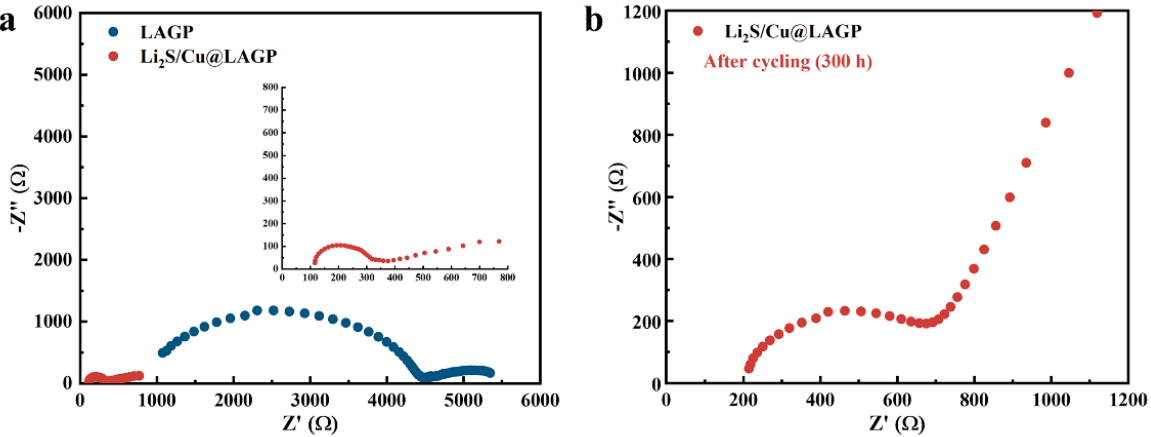
Figure 6. ( a ) Nyquist plots of Li|Li 2 S/Cu@LAGP|Li and Li|LAGP|Li cells. ( b ) Nyquist plot of the Li|Li 2 S/Cu@LAGP|Li cell after cycling for 300 h.